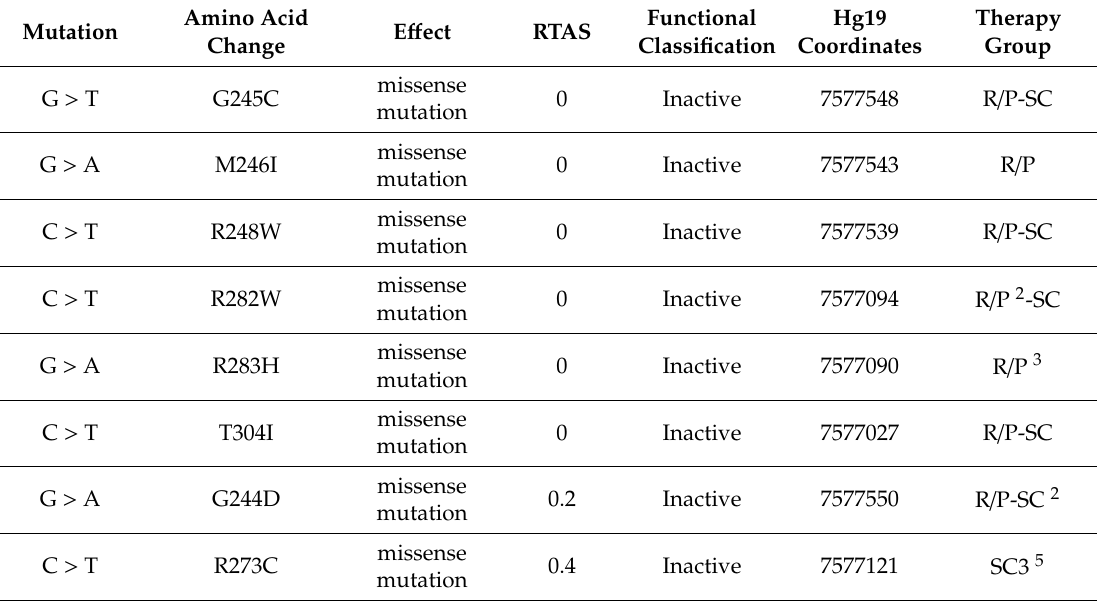
Table 1. Description of the tumor protein p53 ( TP53 ) mutations detected in 70